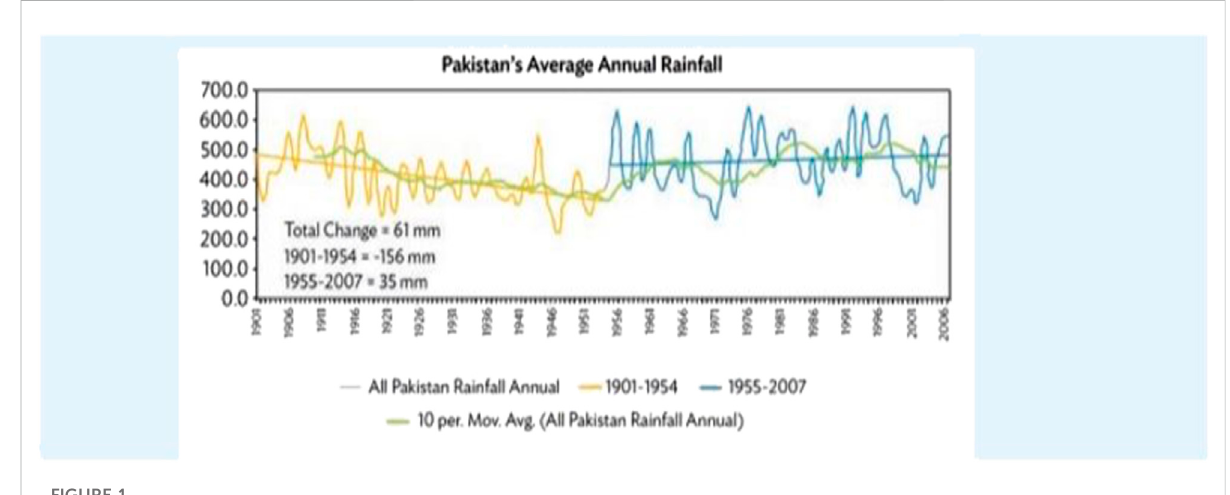
FIGURE 1 Historical precipitation in Pakistan, adapted from ADB (2017).